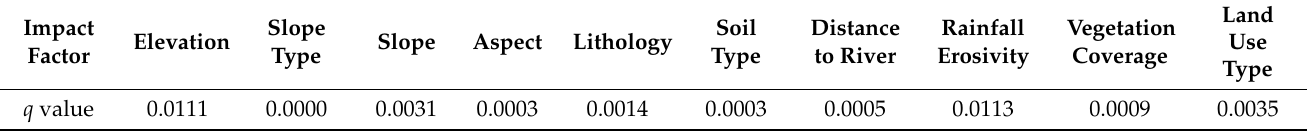
Table 3. Statistical table of q value of 10 factors.